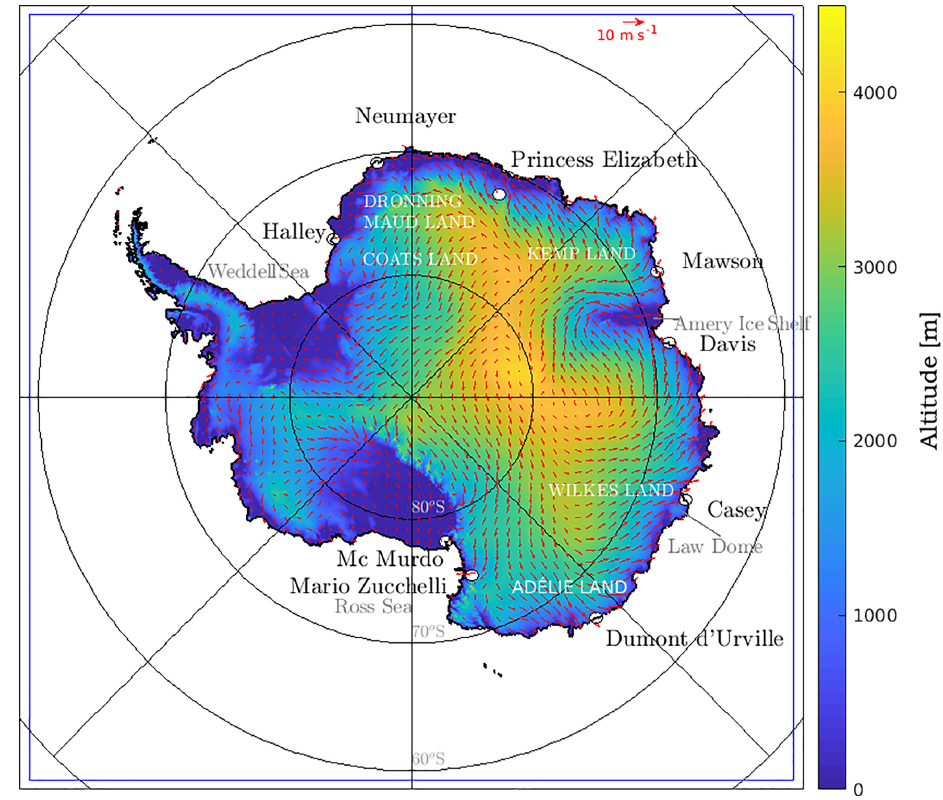
Figure 1. Topography of the Antarctic continent from the Bedmap2 data set at 10km resolution (Fretwell et al., 2013). Black dots indicate stations from which radiosonde data are used in this study. The blue line delimits the Polar WRF simulation domain. Red arrows show the 2010–2017 mean wind vector from ERA5 reanalyses. Table 1. Characteristics of radiosonde data used in this study. “DDU” refers to Dumont d’Urville, “MZ” to Mario Zucchelli and “PE” to Princess Elizabeth station. The indicated time corresponds to the official observation time. Note that sondes are usually launched 45min or 1h before. For each station, the percentage of data indicates the percentage of available radiosoundings in the corresponding period. When two numbers are indicated, the first (second) one corresponds to the percentage of sounding at 00:00UTC (12:00UTC). In the Casey and Mawson data sets, measurements are not provided at constant time or vertical resolution. Subsequently, the averaged number of vertical levels in the first 3000ma.g.l. is indicated in the “resolution”